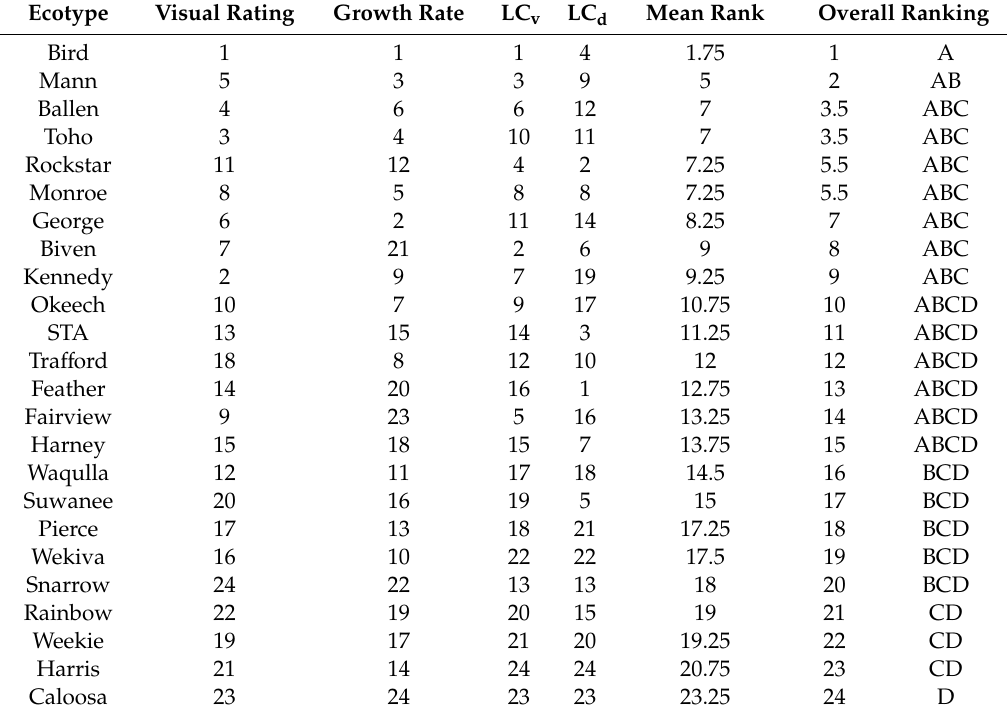
Table 3. Vallisneria americana ecotypes are ranked based on visual rating, growth rate and lethal concentration (LC 50 ) estimated using visual rating (LC v ) and dry weight (LC d ) models. In each column, ecotypes are ranked from best (1) to worst